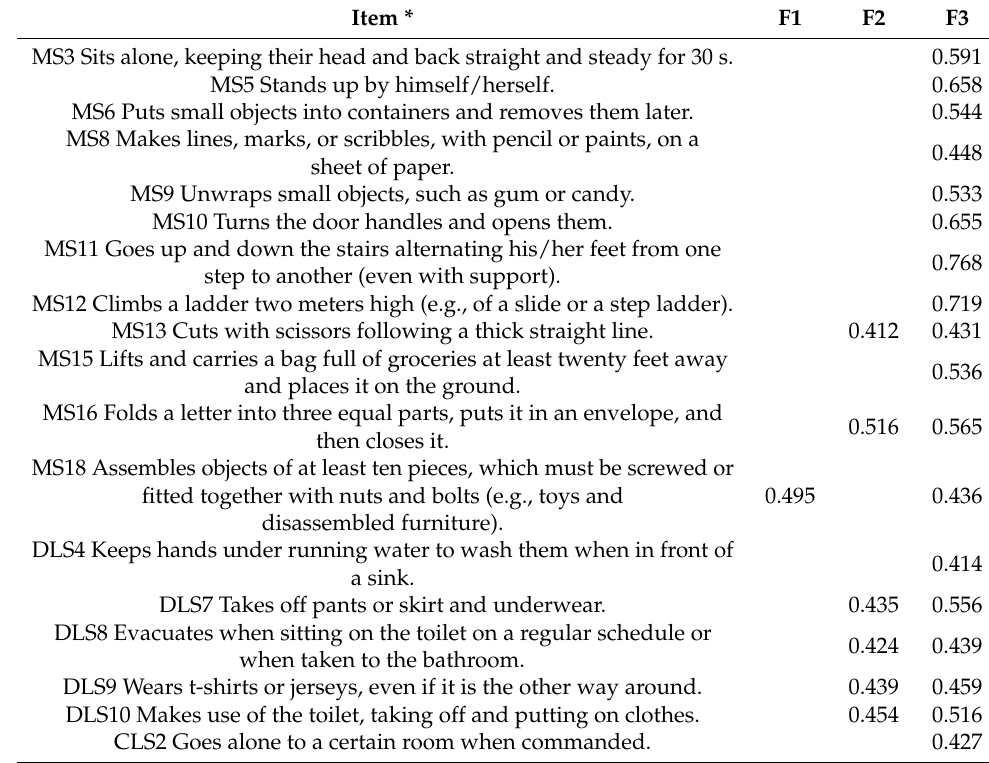
Table 1. Motor skills dimension: items and factor load. Item * F1 F2 F3